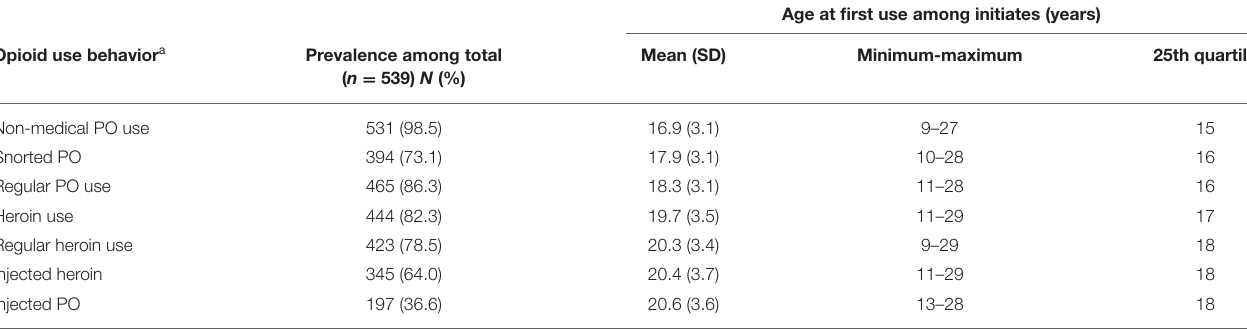
TABLE 3 | Descriptive statistics for age at initiation of opioid use behaviors among young adult opioid users in New York City, 2014–16.